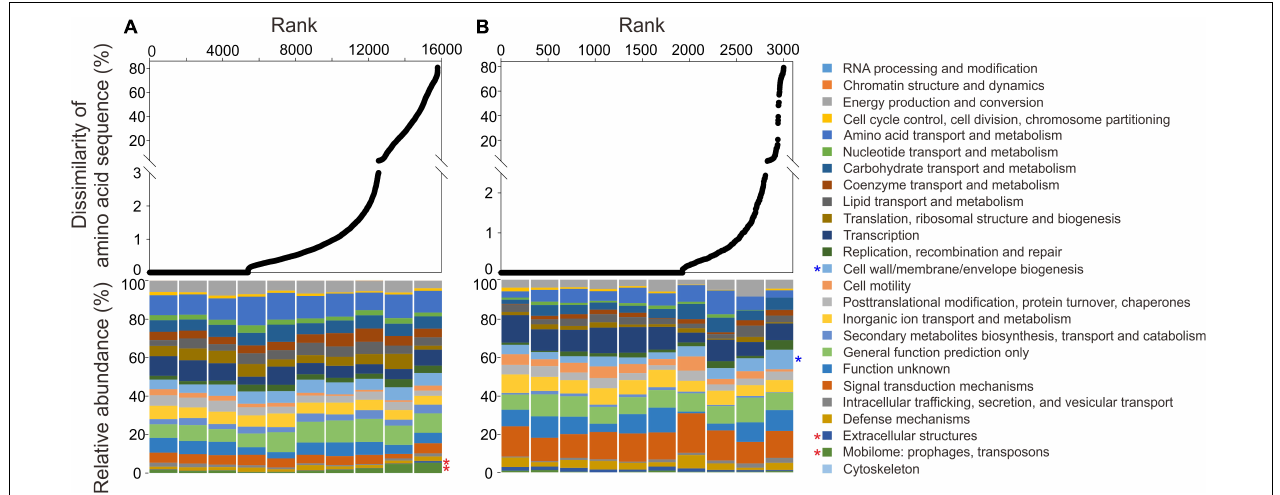
FIGURE 5 | The rank dissimilarity of amino acid sequence to top hit of annotated genes from (A) the hadal Roseobacter SAGs and (B) the hadal Alteromonas SAGs, blasted against the translated gene sequences from closely related reference genomes. The corresponding functional composition (based on COG categories) of ten intervals of the ranked genes is shown in the lower panel. Significantly positive correlations (Pearson correlation test, p < 0.01) between the relative abundance of a functional category and amino acid sequence variation are marked with red asterisks (for Roseobacter ) and blue asterisks (for Alteromonas ). The order of the colors is the same between the legend and the